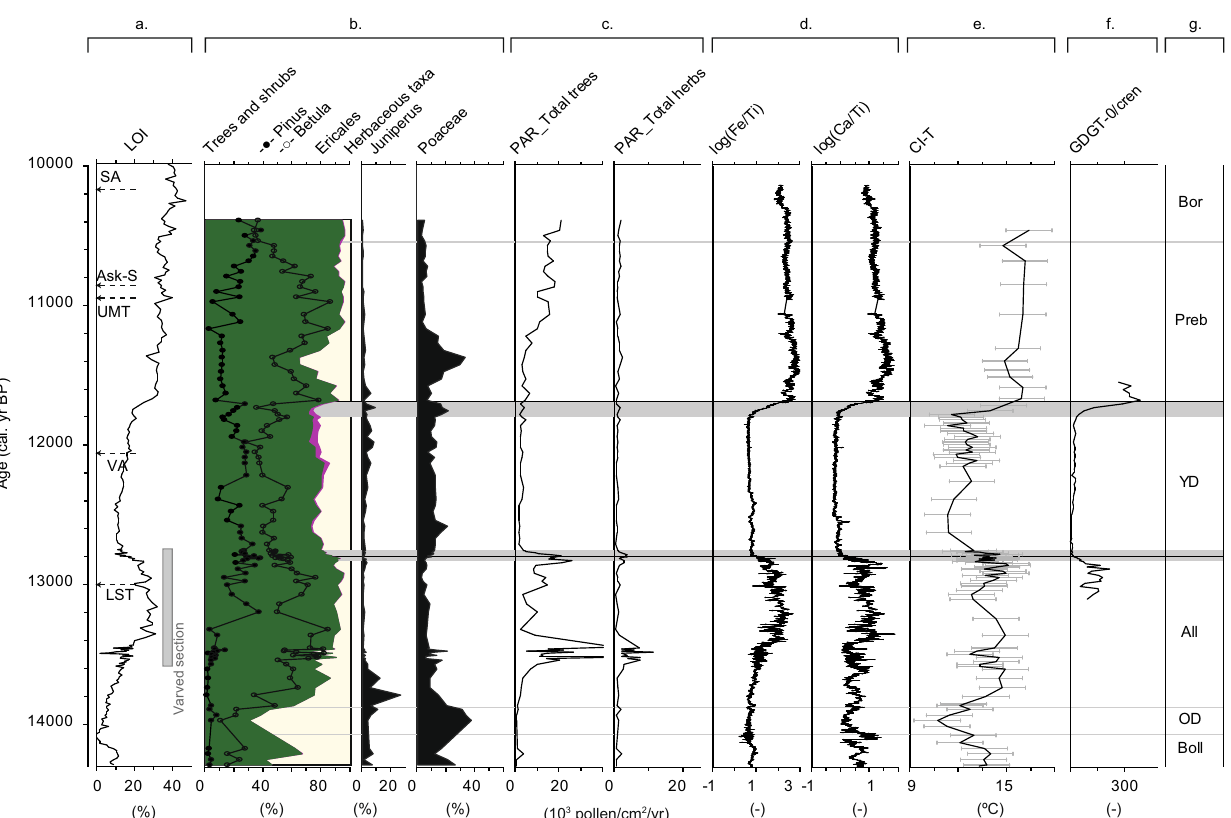
Fig. 2 High-resolution palaeoenvironmental data for the Haem13 lake Hämelsee record, indicating synchronous and abrupt changes in the palaeoenvironmental records at the onset of the YD and the Holocene. Chronological details and selected palaeoecological, geochemical and sedimentological data: a Loss-on-ignition record (see Supplementary Fig. 1 for a detailed lithological column), positions of tephra horizons (black; see Supplementary Table 1 for details) and varved sediment interval (grey); b Pollen percentages of selected taxa; c Pollen accumulation rates (PARs); d µ XRF elemental ratios; e Chironomid-inferred July air temperature (CI-T) with sample-speci fi c error estimates; f GDGT-0 / Crenarchaeol ratio as a proxy for windiness/lake mixing; g Biostratigraphical zonation follows the northwest European Late-Glacial zonation scheme 11 : Boll = Bølling, OD = Older Dryas, All = Allerød, YD = Younger Dryas, Preb = Preboreal, Bor = Boreal. Horizontal grey lines demarcate zonal boundaries, except at the onset and end of the YD, where the grey zones indicate the interval from the earliest changes observed in the pollen assemblages (YD early and Hol early , resp) to the point where a new state of equilibrium is reached (YD eq , Hol eq ) with the black line indicating the location of the transitions sensu stricto (YD SS and Hol SS ; see main text for more